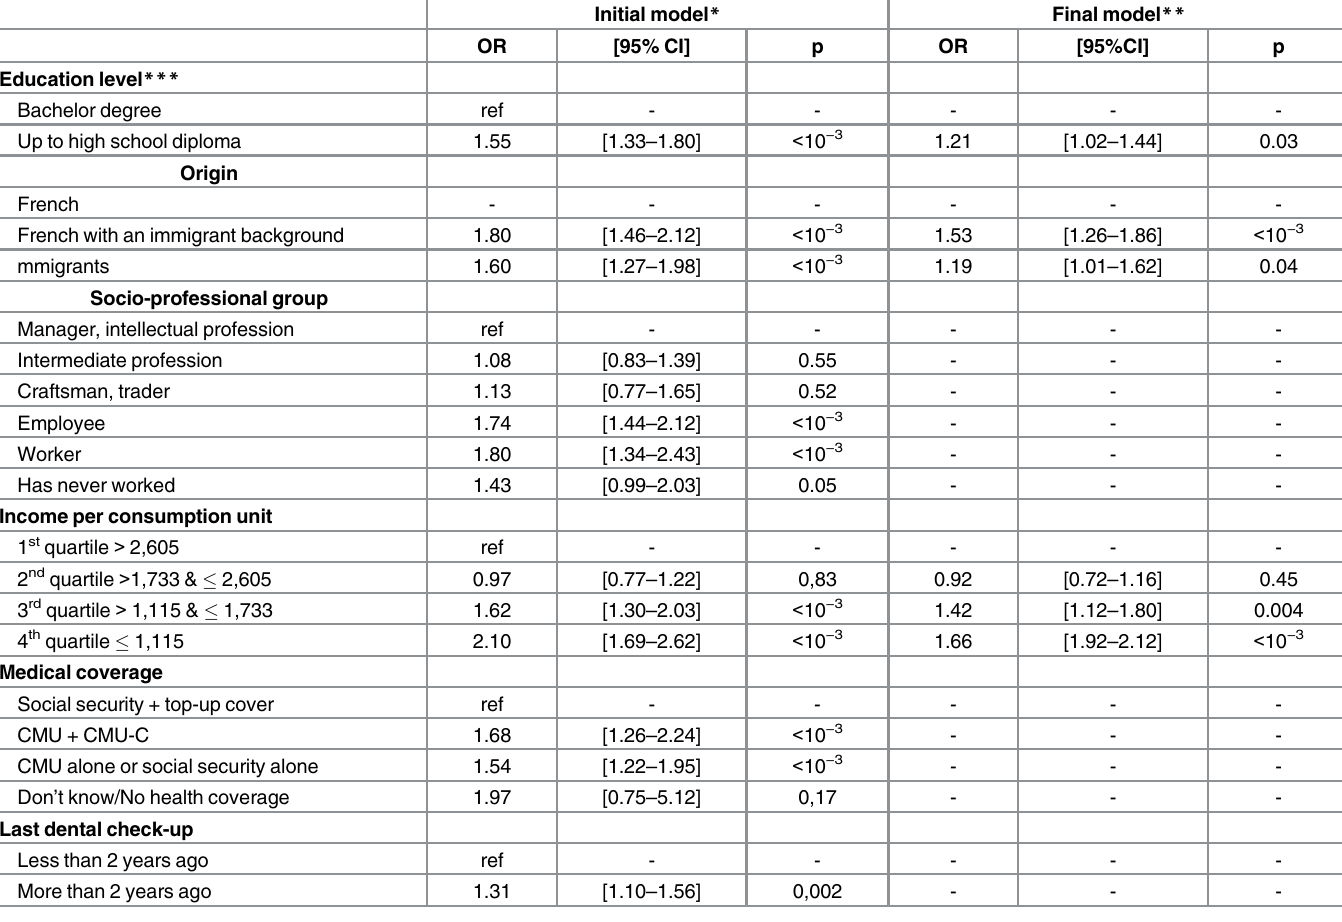
Table 2. Association between the need for oral care and individual socio-demographic characteristics (French SIRS cohort,